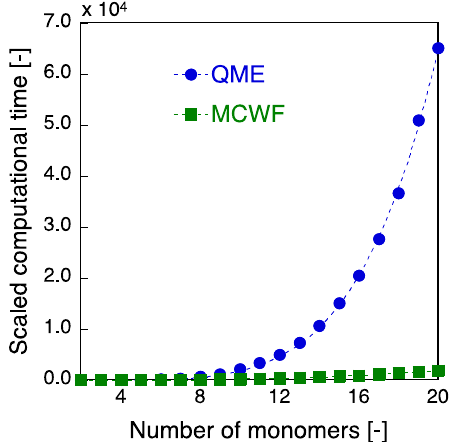
Figure 5. Computational time ( t req ) vs. the size ( N : the number of monomers) of the linear pentacene aggregate model by the QME (with N D = 40) and MCWF (with N D = 700) approaches. All the times are scaled with the computational time at N = 2 (MCWF) as the reference value of 1.0. The fitting curves t req = α N β are also shown by dotted curves (( α , β ) ~ (0.013, 5.15) for the QME vs. (0.188, 3.09) for the MCWF).